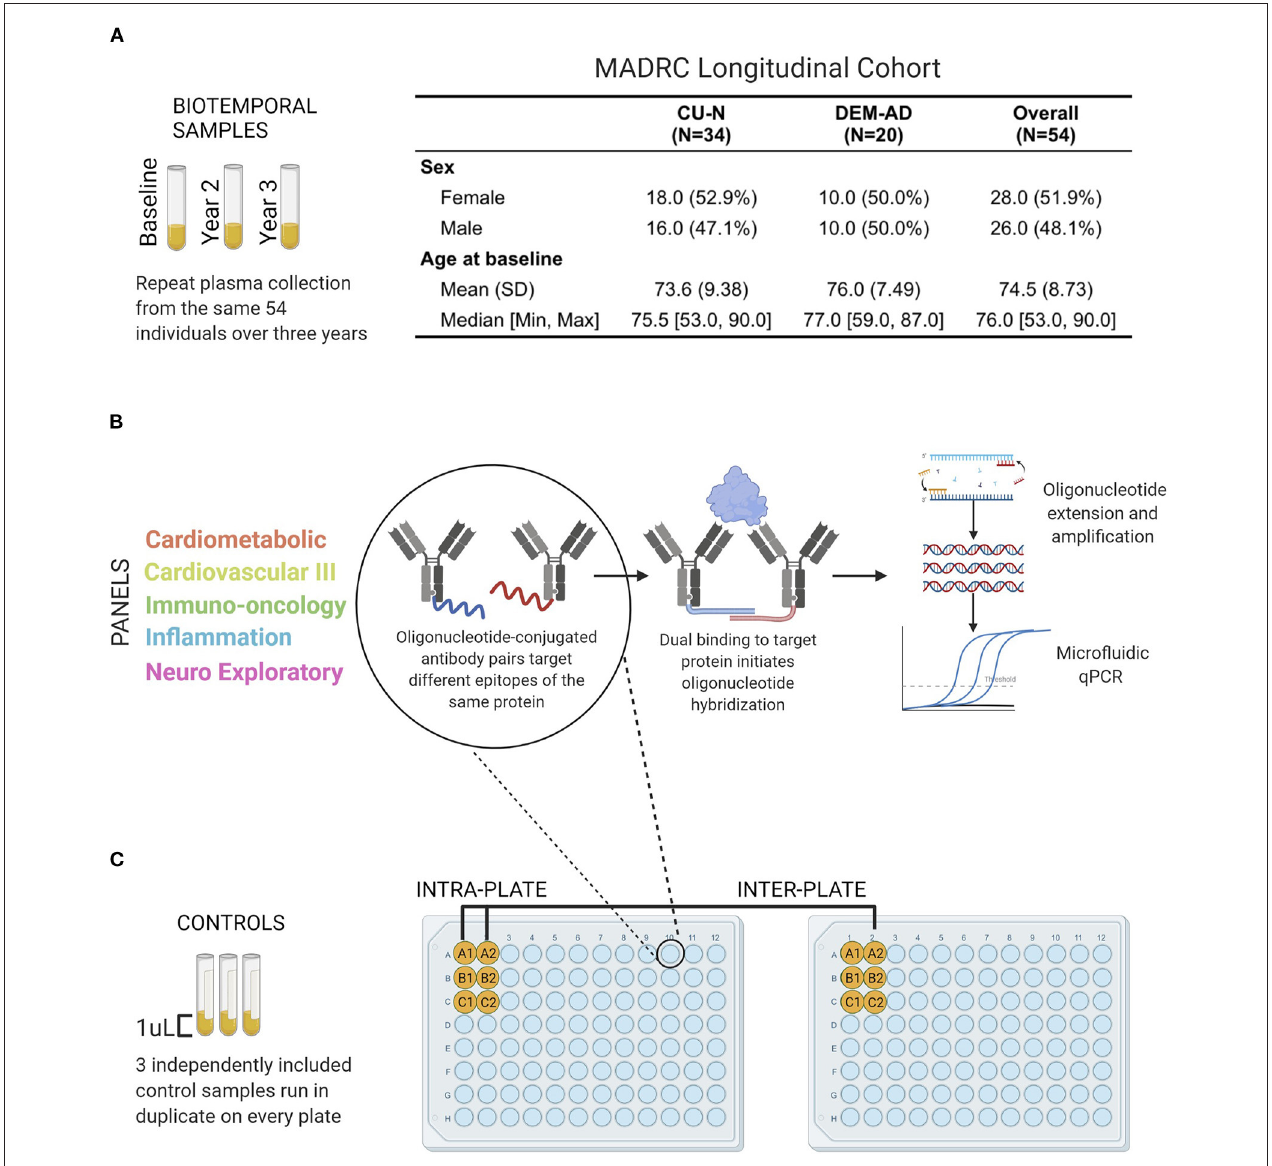
FIGURE 1 | Performance evaluation schematic and Olink Proximity Extension Assay technology overview. (A) Plasma samples from 54 individuals of the Massachusetts Alzheimer’s Disease Research Center Longitudinal cohort were analyzed by Olink PEA technology (B) . Olink PEA technology uses oligonucleotide-conjugated antibody pairs for targeting different epitopes of the same protein. Only when antibody pairs bind the same protein are the oligonucleotides close enough to hybridize. Annealed sequences are then extended, amplified, and measured by microfluidic qPCR. (C) Three control samples were run in duplicate on all plates and panels, allowing independent assessment of intra- and inter-plate assay